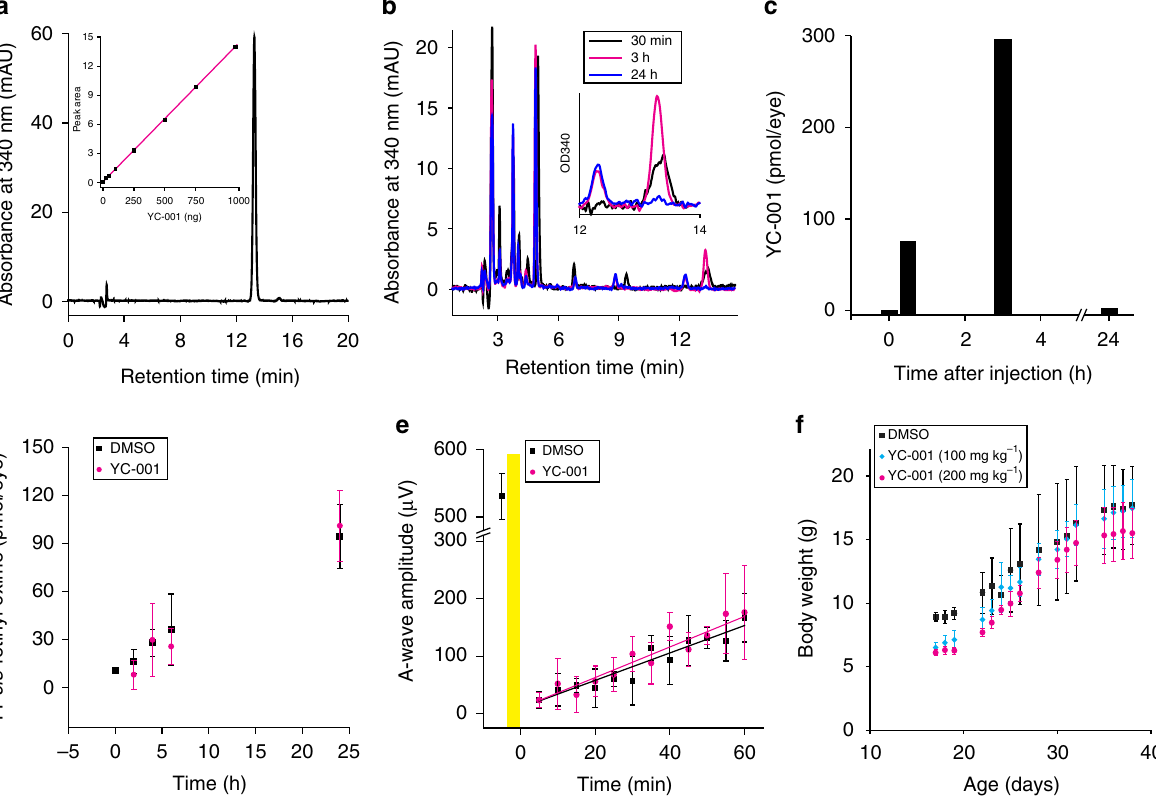
Fig. 7 YC-001 enters mouse eyes without affecting the visual cycle. a HPLC chromatogram of a YC-001 standard indicating a peak at a retention time of 13.2 min with an absorbance at 340 nm. Inset shows the standard curve of YC-001 hexane extracts with its peak area versus its weight in ng. b HPLC chromatogram of hexane extracts from four six-week-old C57BL/6 mouse eyes 0.5, 3, or 24 h after i.p. injection with YC-001 at 200 mg kg − 1 bw in black, magenta, and blue, respectively. The inset is an enlarged chromatogram of the peaks with retention times from 12 to 14 min. c Amounts of YC-001 in pmol per eye plotted as a function of time after injection with YC-001. Time 0 denotes mice not injected with YC-001. d Amounts of 11- cis -retinyl-oxime representing the relative amounts of regenerated rhodopsin pigment were plotted as a function of time after bleaching. Six-week-old C57BL/6 mice were injected with 200 mg kg − 1 bw YC-001 (magenta) or 50 µ L DMSO i.p. 30 min before their exposure to 10,000 lux light for 10 min. Mice then were placed in the dark and euthanized at 0, 2, 4, 6, and 24 h after bleaching. Retinyl-oximes were extracted from homogenized eyes and separated by HPLC. e Recovery of mouse scotopic ERG a-wave amplitude plotted as a function of time after bleaching. Dark-adapted C57BL/6 mice received YC-001 (200 mg kg − 1 bw) or DMSO by ip injection 1 h before light exposure. Mice with dilated pupils were then exposed to 2,000 lux light for 5 min. Yellow shade represents 5 min illumination. Scotopic a-wave amplitude from unbleached dark-adapted mice was shown before time 0. f Bw of YC-001 or DMSO-treated mice plotted as a function of their age. C57BL/6 mice were treated with 100 or 200 mg kg − 1 bw YC-001 by daily i.p. injections, starting on Day 14. Black, DMSO; blue,